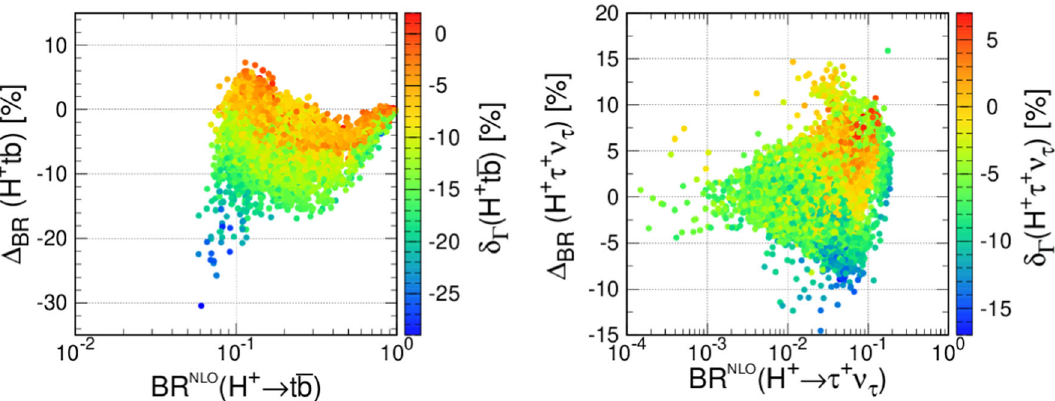
Fig. 2 Relative change in the branching ratio as defined in Eq. (135) for the H + decays into t ¯ b (left) and and τ + ν τ (right) as a function of the respective NLO-corrected (SUSY-QCD and SUSY-EW for the